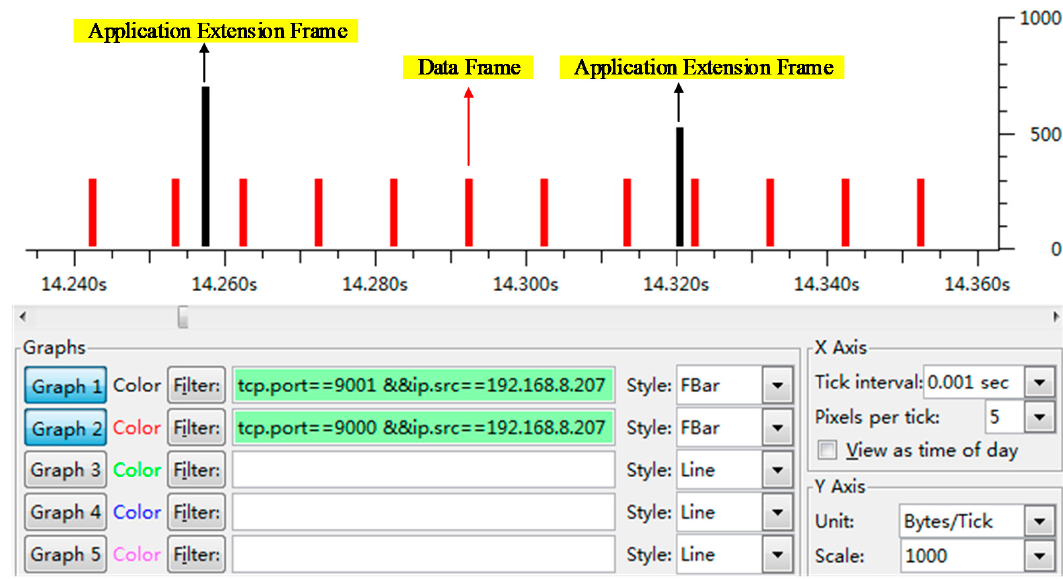
Figure 13. Data frames and application extension frames at a 1 ms time scale level.